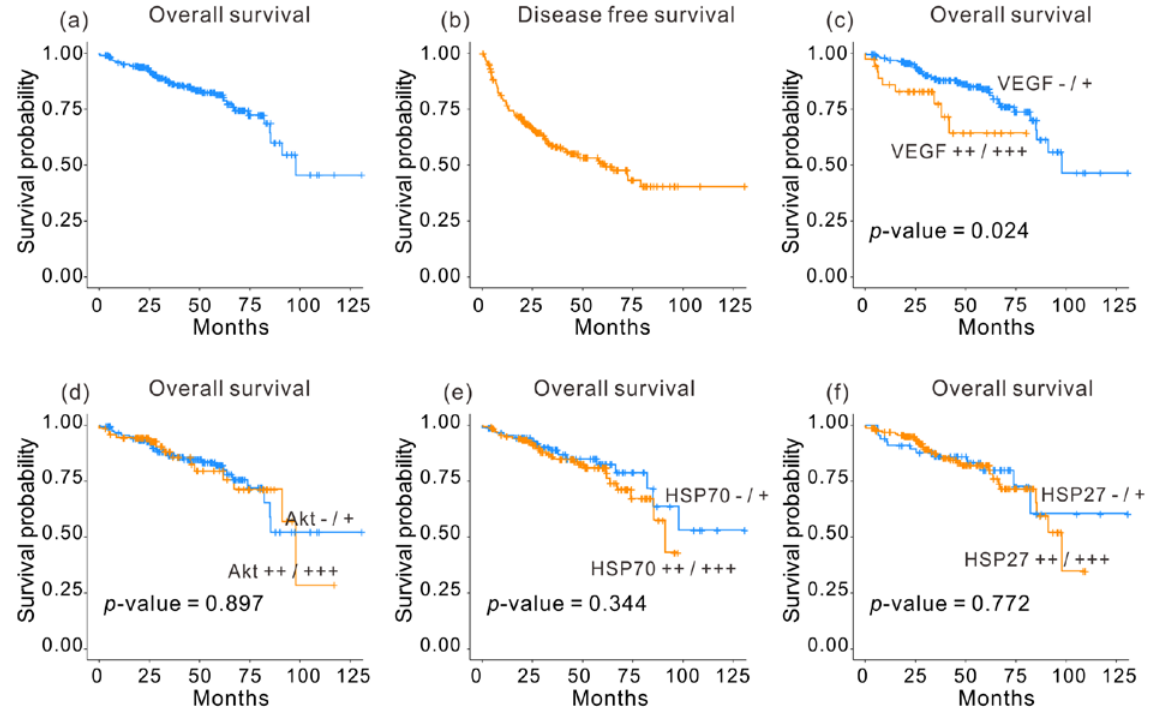
Figure 3: (a) Overall survival curve for the 234 HCC patients following surgical resection, (b) disease-free survival curve, and overall survival curves on the basis of (c) VEGF expression, (d) Akt expression, (e) HSP70 expression, and (f) HSP27 expression.